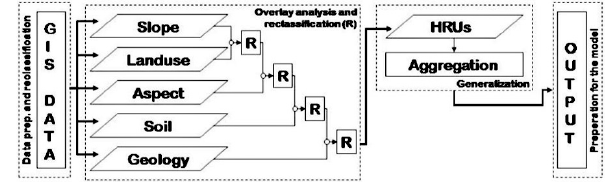
Figure 11. Schema to delineate HRUs.